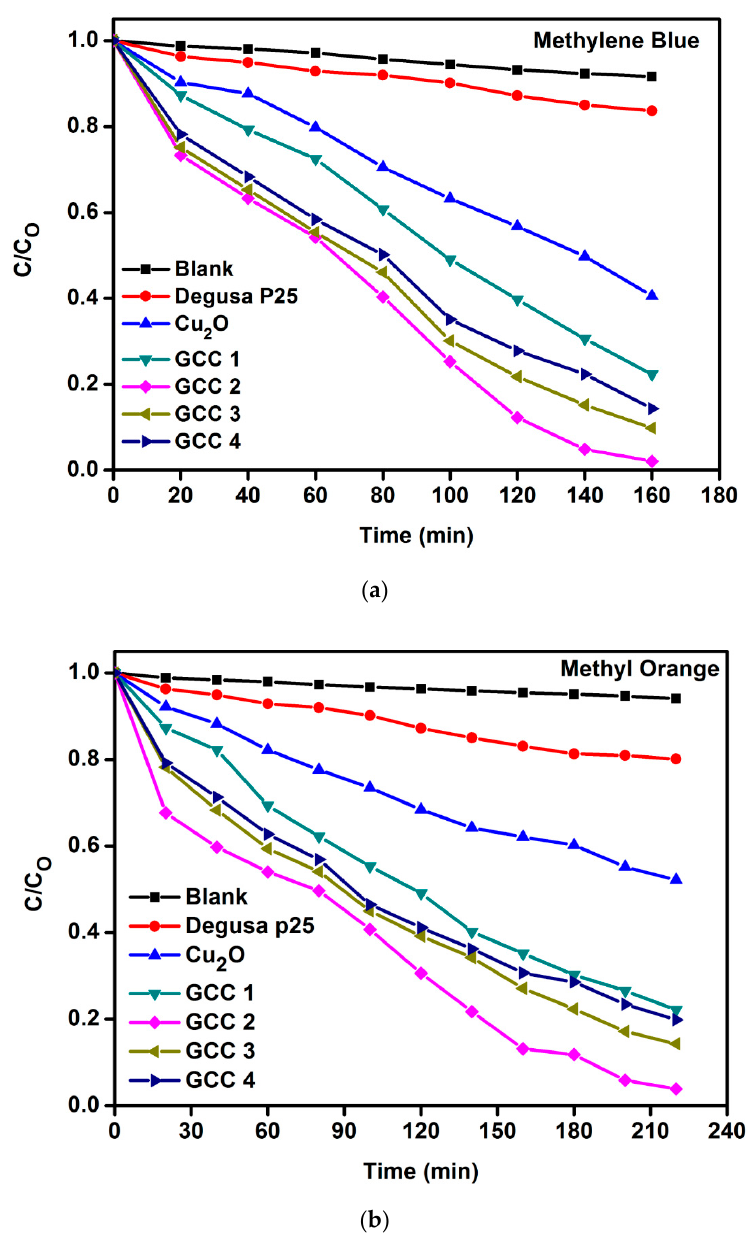
Figure 10. ( a ) C/C 0 versus time for MB dye degradation. ( b ) C/C 0 versus time for MO dye degradation.